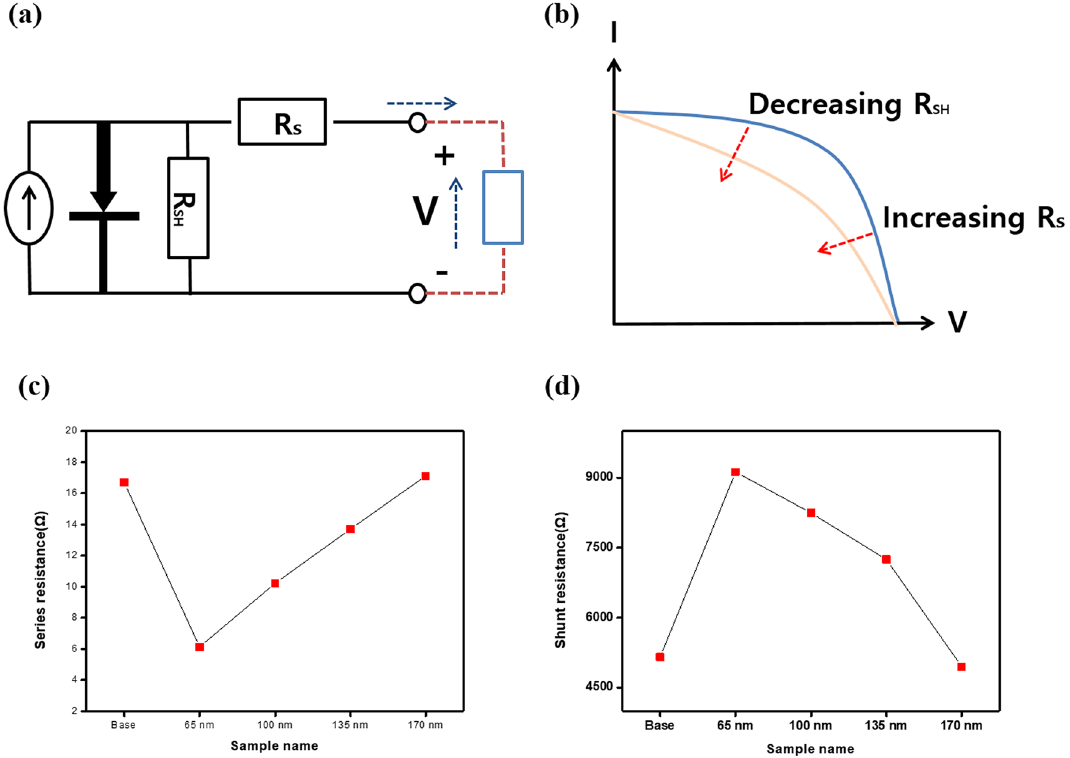
Figure 5. ( a ) The circuit and ( b ) the fill factor curve of the solar cell and ( c ) the series resistance and ( d ) the shunt resistance of the perovskite solar cell with PPL.